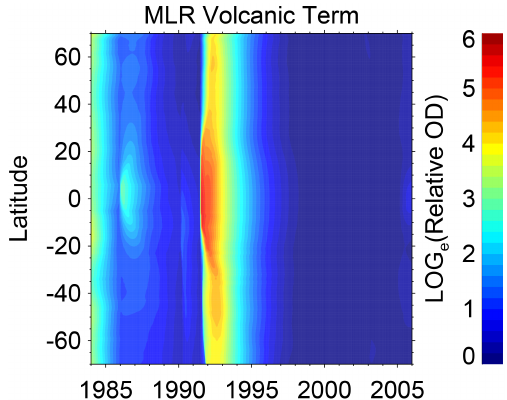
Figure A2. The volcanic term resulting from the STS regression to stratospheric aerosol optical depth in the 1020nm channel. This is the term used as a volcanic proxy term for the regression to ozone data. Relative optical depth means relative to background